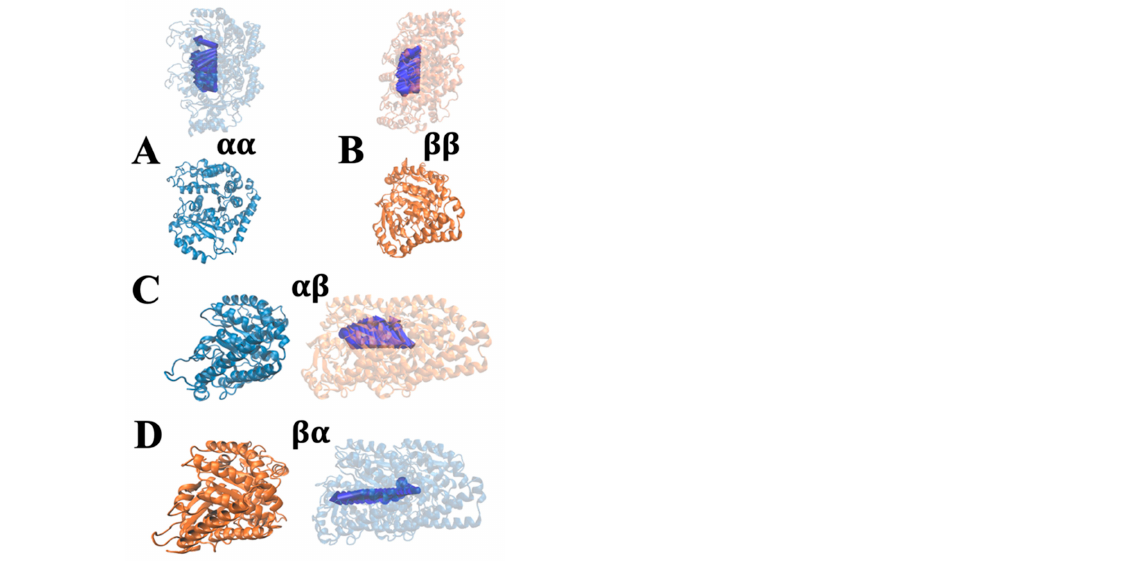
Figure 4. The electrostatic forces between four tubulin complexes ( α / α , β / β , α / β , β / α ). Tubulins are separated at distances from 14 Å to 40 Å with a step size of 2 Å, where the blue arrows show the net force directions. The electrostatic forces are shown for ( A ) α / α , ( B ) β / β , ( C ) α / β , and ( D ) β / α complexes.